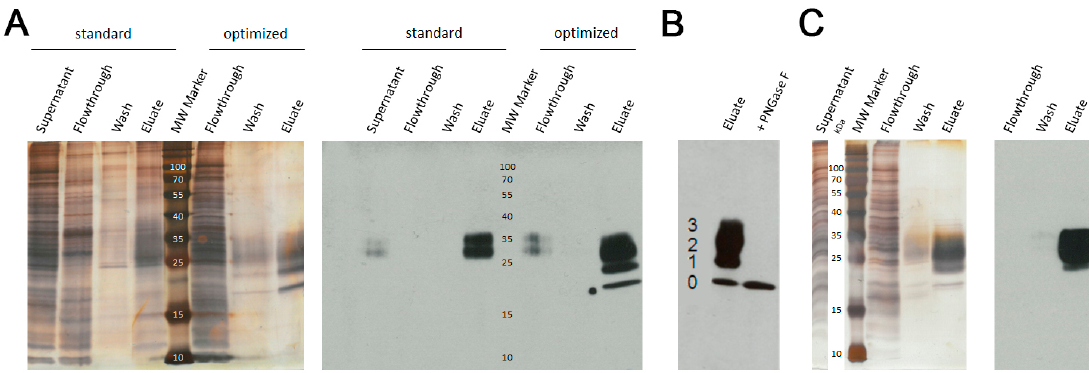
Figure 1. Verification of protein purity and identity after ( A ) Ni-NTA chromatography. Left, silver stained SDS-PAGE and right, respective immunoblot detecting L -selectin LE-His. Standard and optimized purification protocols are compared. The molecular weight (MW) marker is given in kDa; ( B ) Endoglycosidase digest of elute. Numbers indicate the different glycoforms of L -selectin LE-His, 0: no N -glycans, 1: one N -glycan, 2: two N -glycans, 3: three N -glycans; ( C ) AAC chromatography. Left, silver stained SDS-PAGE and right, respective immunoblot detecting L -selectin LE-His. The molecular weight (MW) marker is given in kDa.